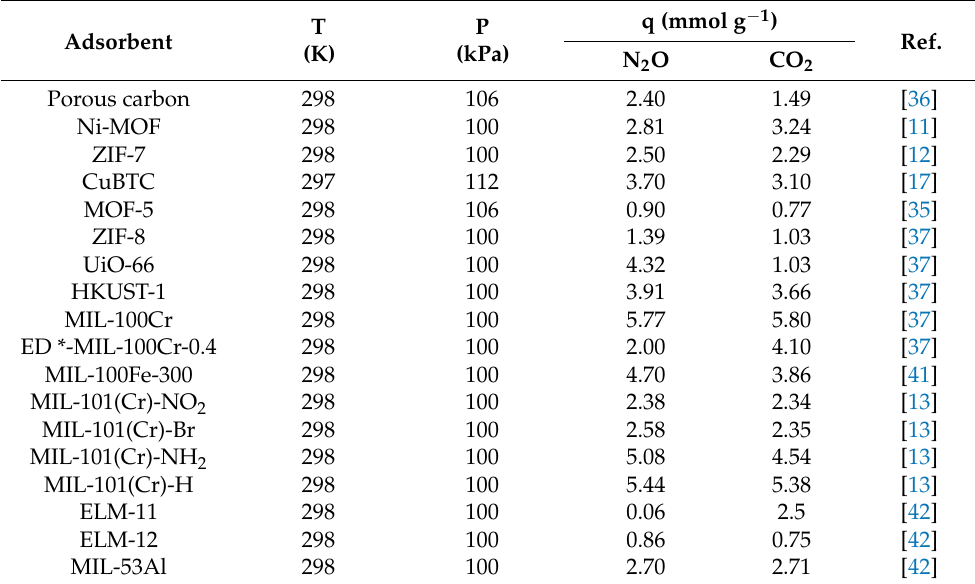
Table 6. Adsorbed amount of N 2 O and CO 2 in separation processes. Adsorbent